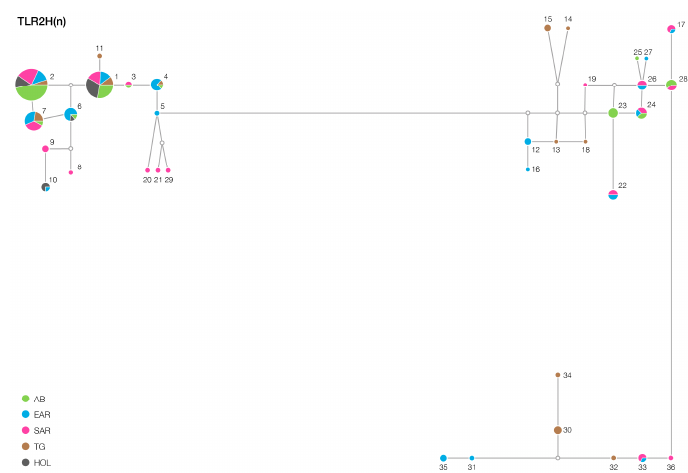
Figure 4. Median joining network constructed on the basis of 36 haplotype of TLR2 . Filled circles represent haplotypes, and areas within circles are proportional to the number of individuals. The length of the lines connecting haplotypes and branching points correlates approximately with the number of base substitutions .